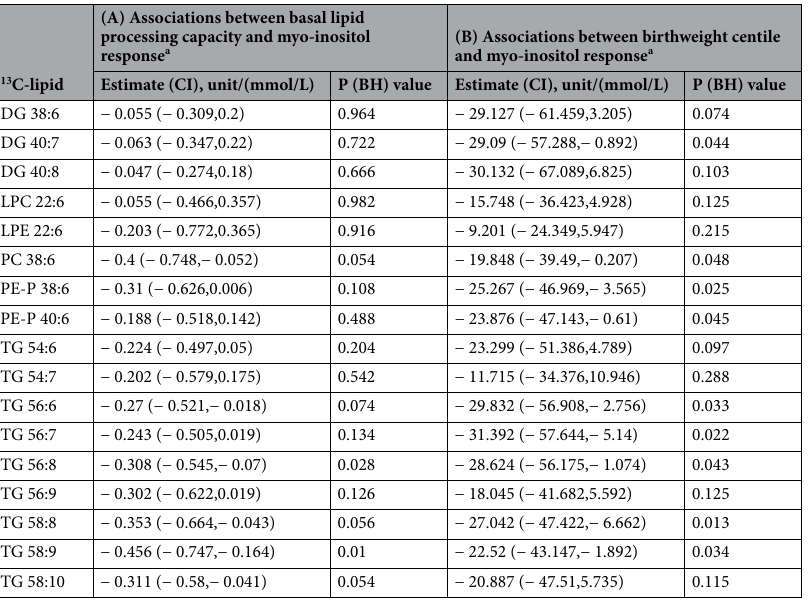
Table 2. Association of basal lipid processing capacity in control explants with myo-inositol response and the association of myo-inositol response with birthweight centile. DG: diacylglycerols, DHA: docosahexaenoic acid, LPC: lyso-phosphatidylcholine, LPE: lyso-phosphatidylethanolamine, PC: phosphatidylcholine, PE: phosphatidylethanolamine, PE-P: phosphatidylethanolamine plasmalogen, TG: triacylglycerol. a Myo-inositol response represents the relative amount of 13 C-DHA lipid in placental explants treated with myo-inositol (60 µmol/L) compared with control explants from the same placenta not treated with myo-inositol. (A) Linear regression was run with myo-inositol response (log2-fold-change) as the outcome and basal lipid processing (calculated by the formula ( 13 C-DHA/( 13 C-DHA + 12 C-DHA)) Z-score, log2 transformed) as the predictor variable. Basal lipid processing capacity was measured in control explants with no additional myo-inositol. (B) Linear regression was run with birthweight centile as the outcome and myo-inositol response as the predictor variable. Birthweight centile was standardized for sex and gestational age using local references 65,66 . The Benjamini-Hochberg (BH) method was used to correct for multiple